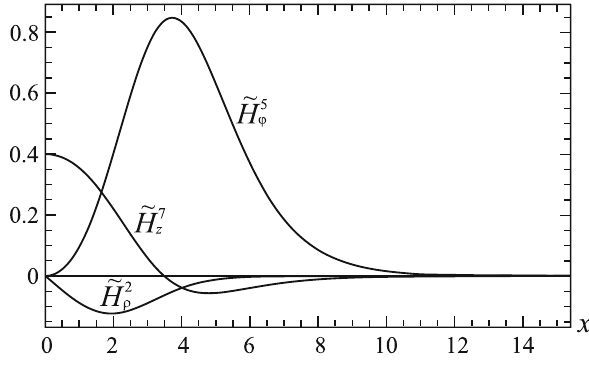
Fig. 8 The profiles of the color magnetic fields ˜ H 2 ρ ≡ gH 2 ρ /φ 2 ( 0 ), ˜ H 5 ϕ ≡ gH 5 ϕ /φ( 0 ) , and ˜ H 7 z ≡ gH 7 z /φ 2 ( 0